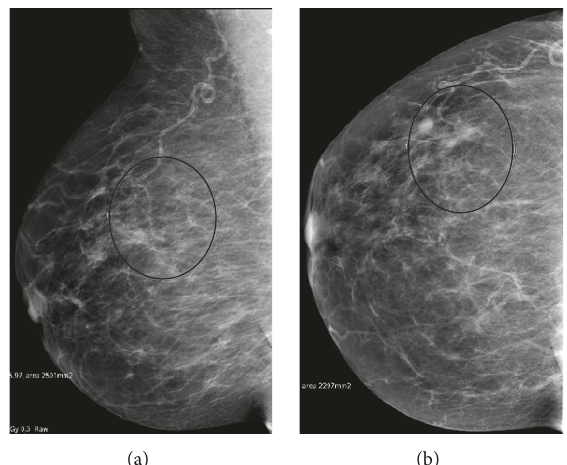
Figure 1: MLO (a) and CC (b) mammogram views of the right breast revealed right upper outer mid and posterior third regional clusters of microcalcifications (circle) with underlying increased density associated with partially marginated nodule; the imaging appearance is suspicious.